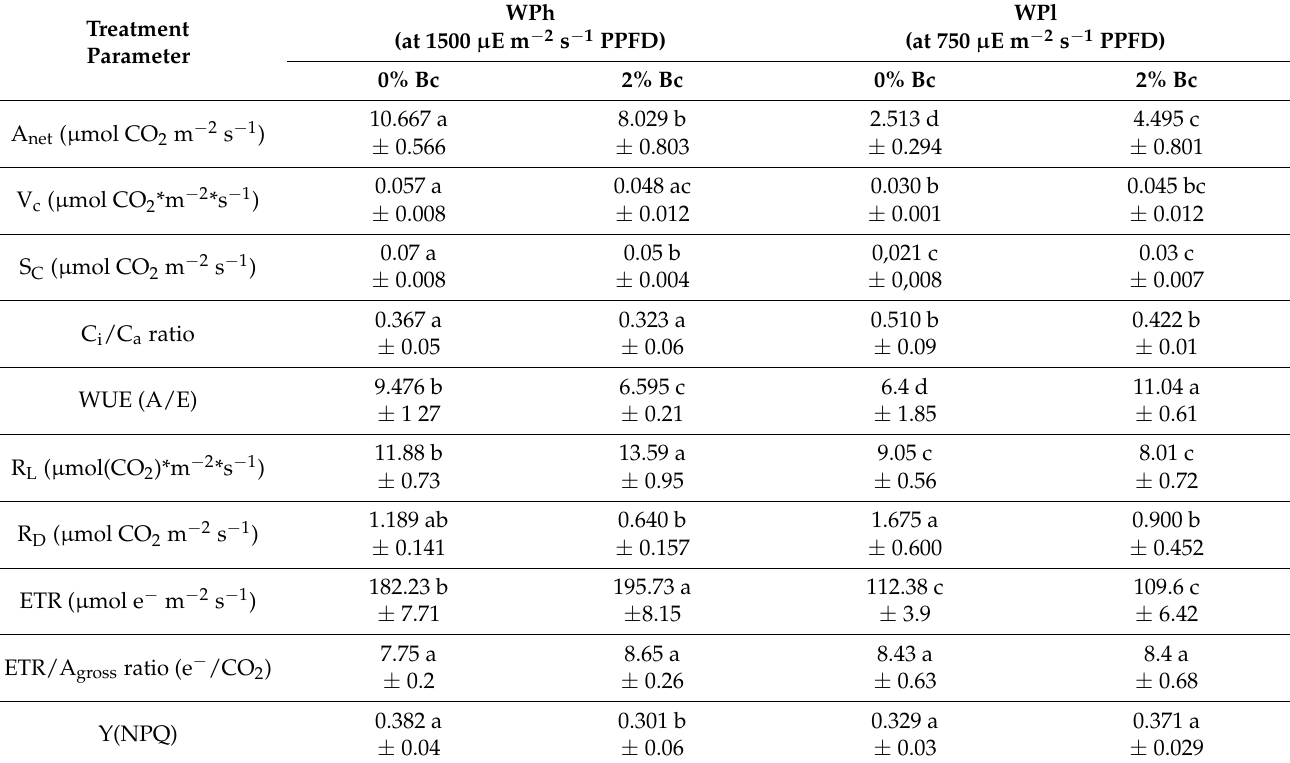
loss in PS II (Y(NPQ)), electron (e −